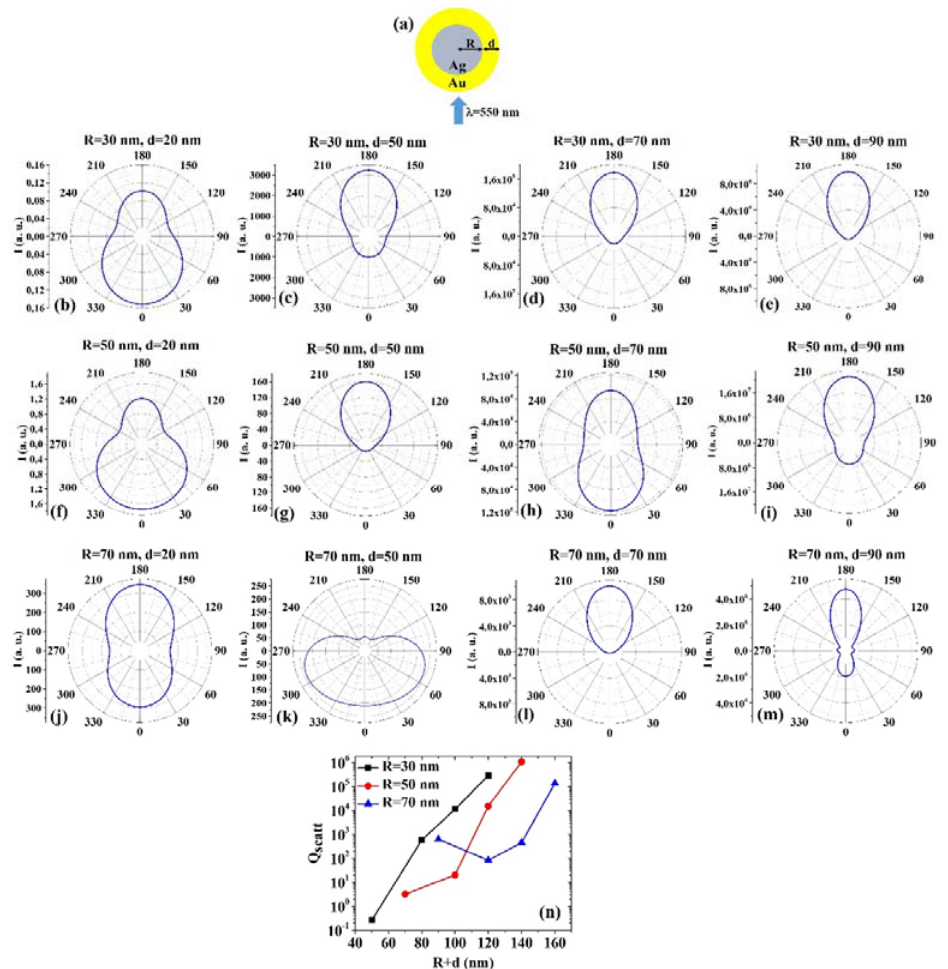
Figure 2. ( a ) Scheme of the structure of the simulated Ag/Au core/shell spherical particle with core radius R and shell width d and electromagnetic radiation of wavelength λ = 550 nm impinging on the particle from 0 ◦ . ( b – m ) Calculated polar diagrams for the intensity of the scattered light from the Ag/Au core/shell spherical particle changing the Ag core radius R and the Au shell width: ( b – e ) R = 30 nm and d = 20 nm ( b ), d = 50 nm ( c ), d = 70 nm ( d ), d = 90 nm ( e ); ( f – i ) R = 50 nm and d = 20 nm ( f ), d = 50 nm ( g ), d = 70 nm ( h ), d = 90 nm ( i ); ( j – m ) R = 70 nm and d = 20 nm ( j ), d = 50 nm ( k ), d = 70 nm ( l ), d = 90 nm ( m ). ( n ) Calculated scattering efficiency for the light (wavelength λ = 550 nm) scattering process of the Ag/Au spherical particle fixing the Ag core diameter (R = 30 nm black dots, R = 50 nm red dots, R = 70 nm blue dots) and increasing the Au shell width d from 20 nm to 90 nm. (3) CuAg: Figure 3a shows the picture of the structure of the Cu/Ag core/shell spher- ical particle for which the simulations are performed with R the core radius and d shell width. The electromagnetic radiation of wavelength λ = 550 nm impinges on the particle from 0°. In addition, Figure 3b–m presents the calculated polar diagrams for the intensity of the scattered light from the Cu/Ag core/shell spherical particle changing the Cu core radius R and the Ag shell width (i.e., fixing R to 30 nm or 50 nm or 70 nm and increasing d from 20 nm to 90 nm). Finally, Figure 3n presents the calculated scattering efficiency values for the light (wavelength λ = 550 nm) scattering process of the Cu/Ag spherical particle fixing the Au core diameter (R = 30 nm black dots, R = 50 nm red dots, R = 70 nm blue dots) and increasing the Ag shell width d from 20 nm to 90 nm. In this case, we observe, in particular, that fixing R = 30 nm, the intensity I of the scattered radiation is maximum for θ = 0° when d = 20 nm and I is maximum for θ = 180° when d = 50 nm, d = 70 nm, d =9 0 nm. Setting R=50 nm, I is maximum for θ = 0° when d